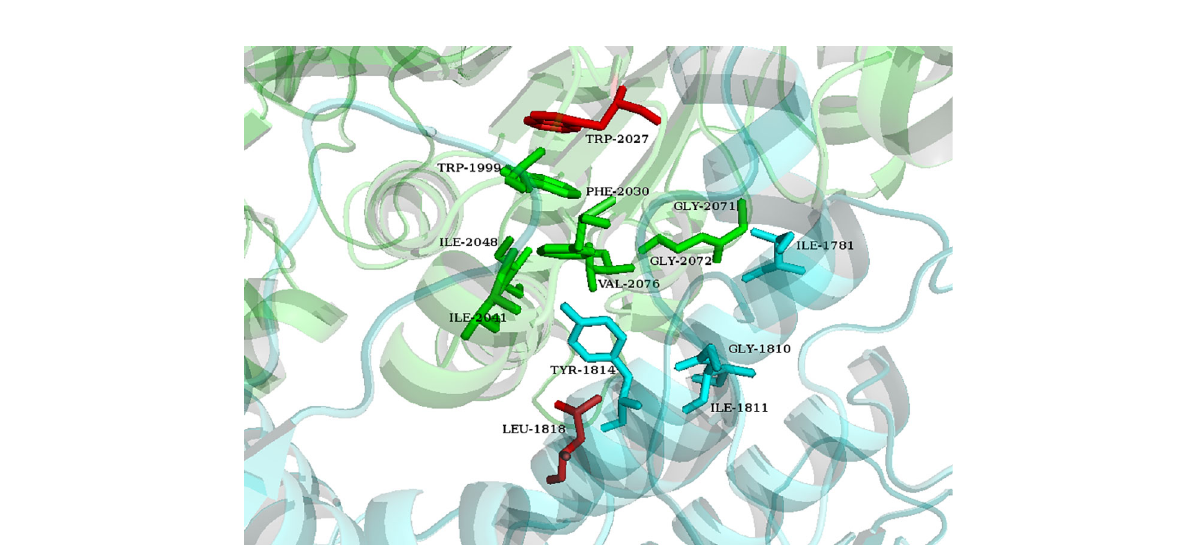
FIGURE 4 Predicted structure of the substrate-binding pocket in wild-type Leptochloa chinensis ACCase. The N and C domains of two ACCase monomers are indicated in blue and green, respectively. Amino acids in the active site region are represented by sticks. Stick color indicates the domain in which the amino acids reside. Two detected mutations are displayed as red